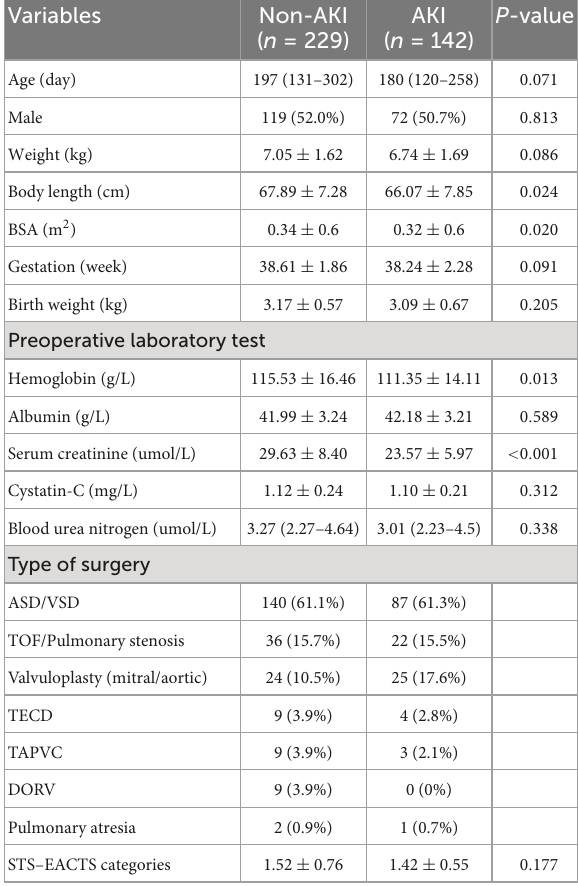
TABLE 1 Baseline characteristics of the patients.